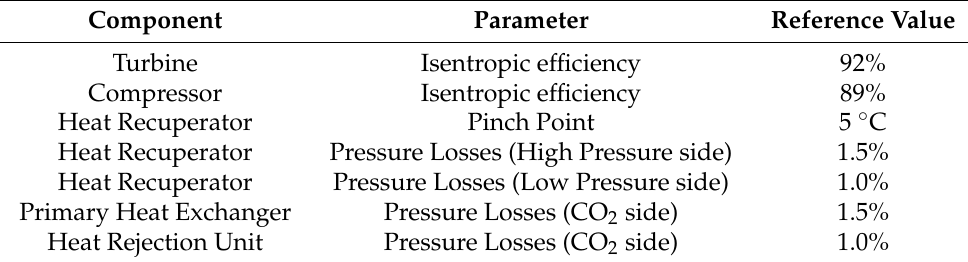
Table 1. Set of boundary conditions for sCO 2 power cycles.